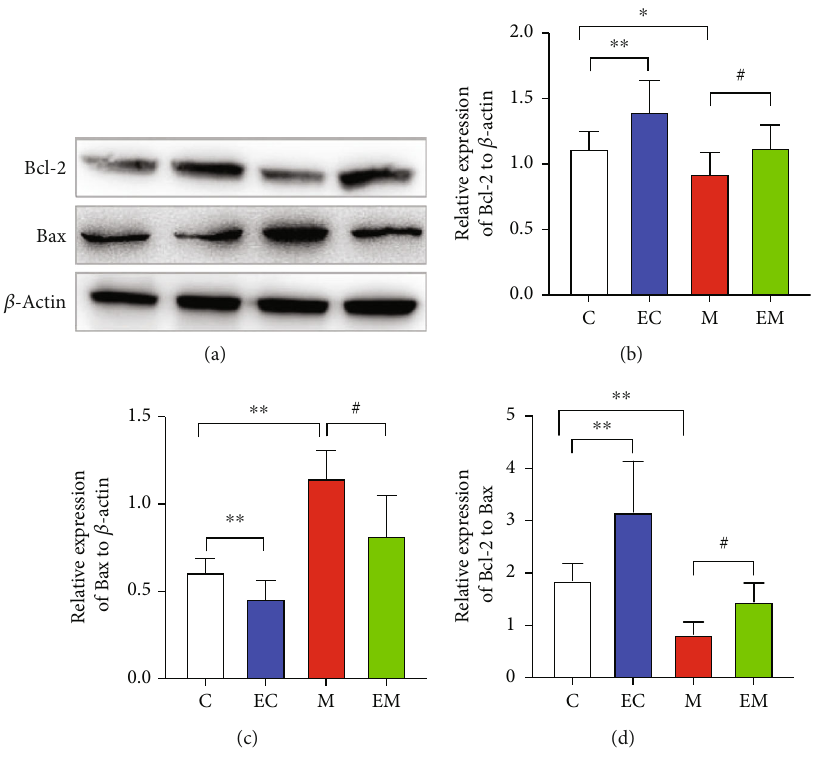
Figure 5: Expression of apoptotic proteins Bcl-2, Bax, and Bcl-2/Bax in the hippocampus of various groups of mice. (a) Western blot analysis, Bcl-2, and Bax images. (b – d) Bcl-2, Bax protein expression, and Bcl-2/Bax levels in each group of mice. β -Actin was used as an internal reference protein, and the data are mean ± SD ( n = 8/group ). ∗ P < 0 : 05 and ∗∗ P < 0 : 01 vs. group C; # P < 0 : 05 and ## P < 0 : 01 vs. group